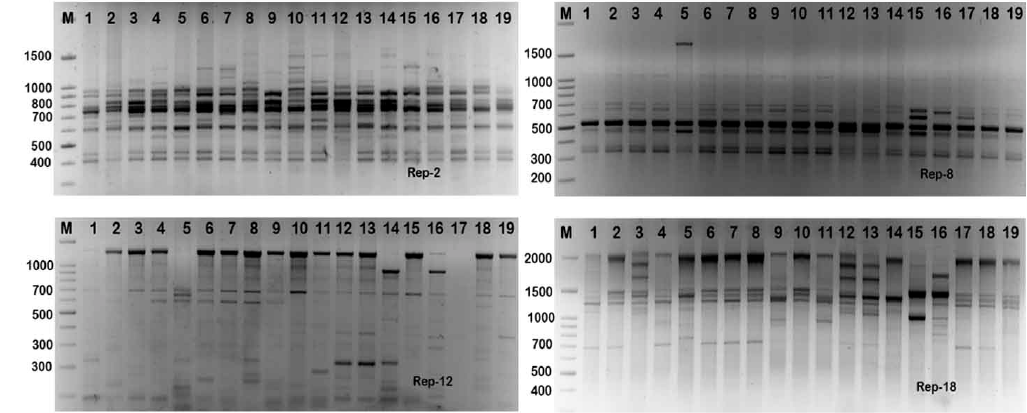
Fig. 5. Rep-PCR profile of 19 Enterococcus spp . isolates generated with four rep primers, rep-1, rep-2, rep-8, rep-12 and rep-18, respectively. First lane on each panel is 100 bp molecular weight markers.